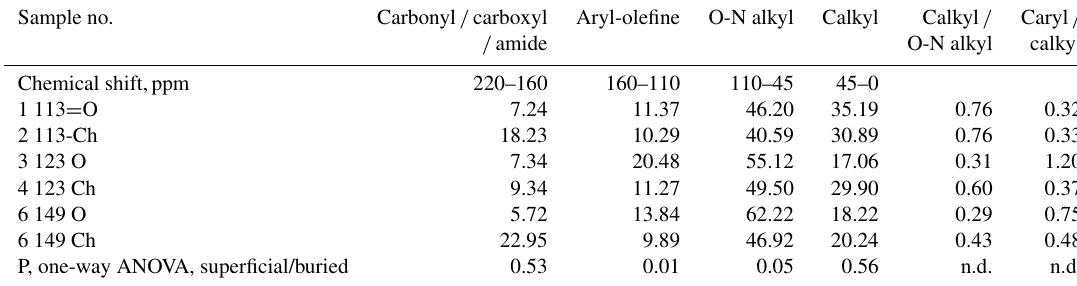
Figure 4. 13 C NMR spectra of bulk organic matter of soils (labelled 1–6 according to Table 1). [CRH] represents the buried humic cryogenic horizon. Table 4. Carbon species integration in molecules of the bulk organic matter, %. Sample